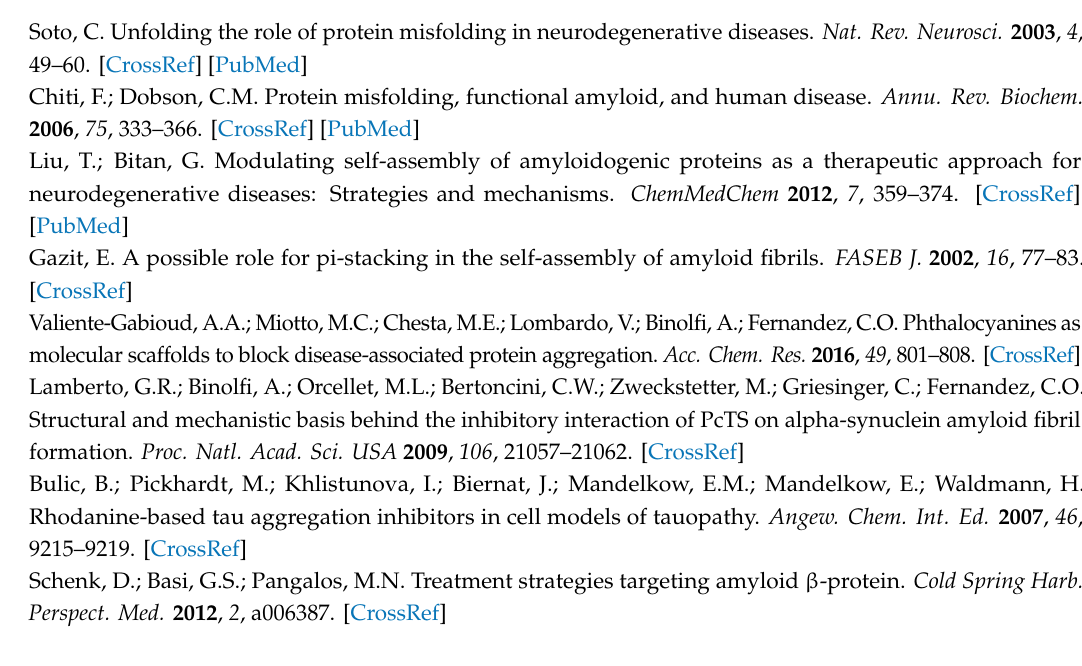
s1. Figure S1. Overlaid contour plots of 1 H- 15 N HSQC spectra of 50 µ M wt (black) and Y39L α S (red), showing all amide resonances detected. Most-a ff ected residues located in the vicinity of the mutated site are labeled. Figure S2. Secondary structure content for individual residues across the four species investigated here during the simulation. Table S1. Characteristics of the RG and EE distributions across the four variants. The centers depicted in Figure 6 are described as the respective joint distributions. Additionally, the values of the mode and average of the marginal distributions (the univariate, independent ones) are depicted below. The conclusions of the study were based on the joint distribution of EE and RG. Table S2. Intramolecular HB content for the four variants within the structural ensemble. Table S3. Intramolecular hydrophobic contacts for the four variants within the structural